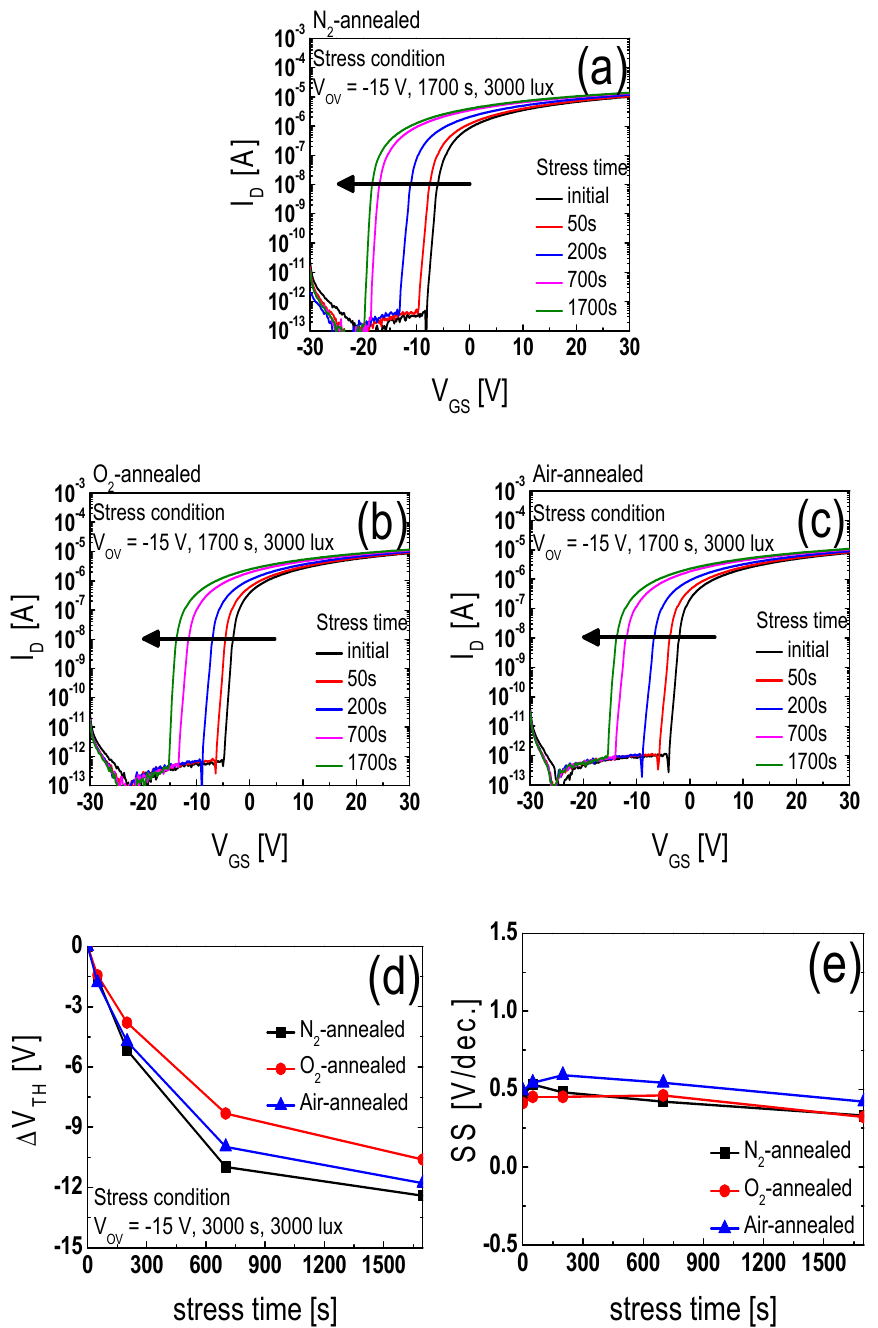
Figure 4. Time-dependence of transfer characteristics of ( a ) N 2 -, ( b ) O 2 -, and ( c ) air-annealed IGTO TFTs after the application of a constant bias stress V OV = –15 V under illumination by a LED backplane unit with a brightness of 3000 lx. ( d ) ∆ V TH values obtained for the N 2 , O 2 , and air annealed IGTO TFTs after subjection to negative bias illumination stress (NBIS) various times. ( e ) The SS values obtained for the N 2 -, O 2 -, and air annealed IGTO TFTs at every NBIS